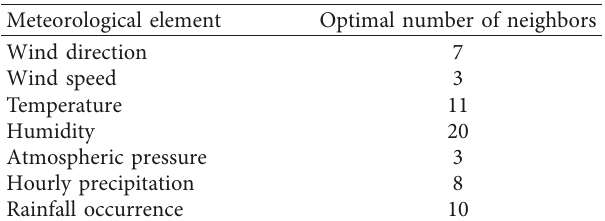
Table 12: Accuracy of estimated values based on the size of the training set (RMSE).